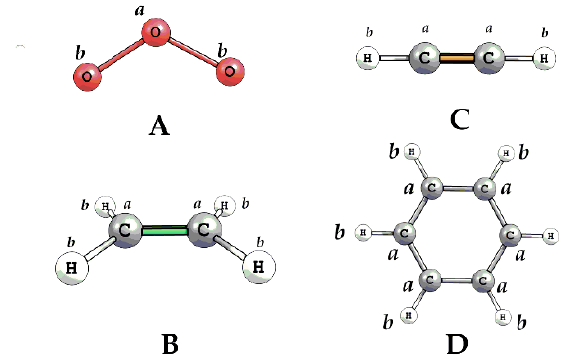
Fig. 3. Two pairs of similar isentropic molecules: ozone ( A ) and ethylene ( B ), acetylene ( C ) and benzene ( D ). Explanations are in the text. Inequivalent atoms in the molecules are lettered.